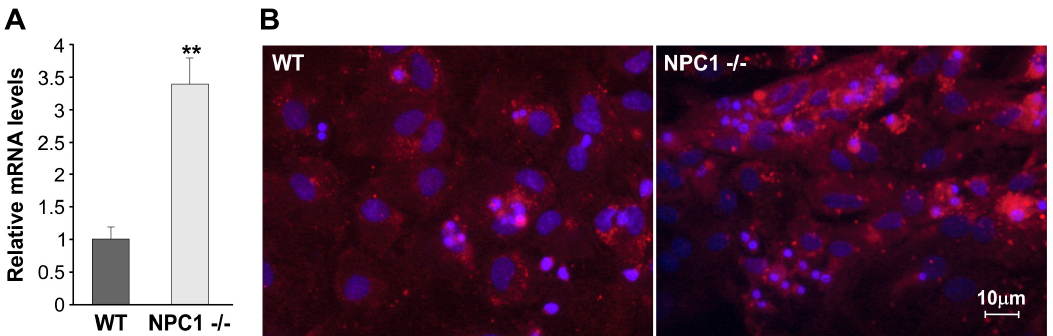
Figure 4. LOX-1 expression in hippocampal cells obtained from WT and NPC1 − / − mice. ( A ) RT-qPCR analysis. Values represent mean ± SEM. Data are representative of three independent replicates. (** p < 0.05); ( B ) Representative images of immunocytochemical analyses performed using anti